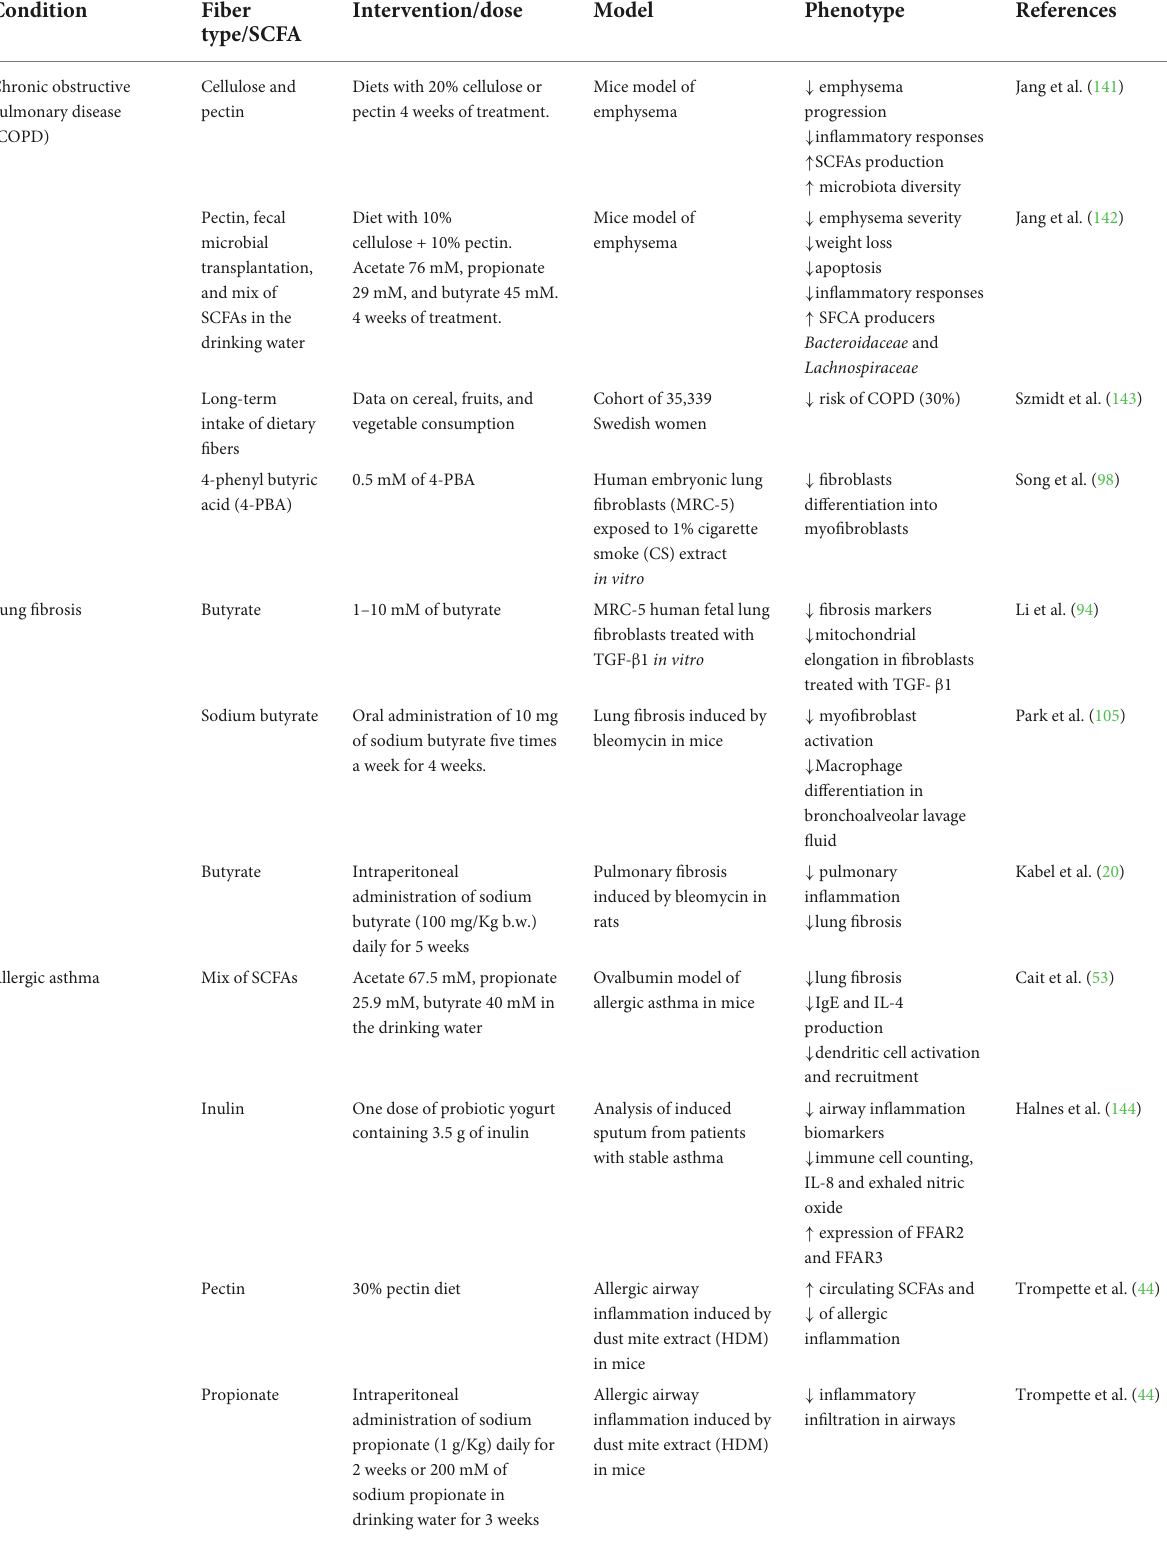
TABLE 1 In vitro and in vivo effects of short-chain fatty acids (SCFAs) on distinct pulmonary disorders.